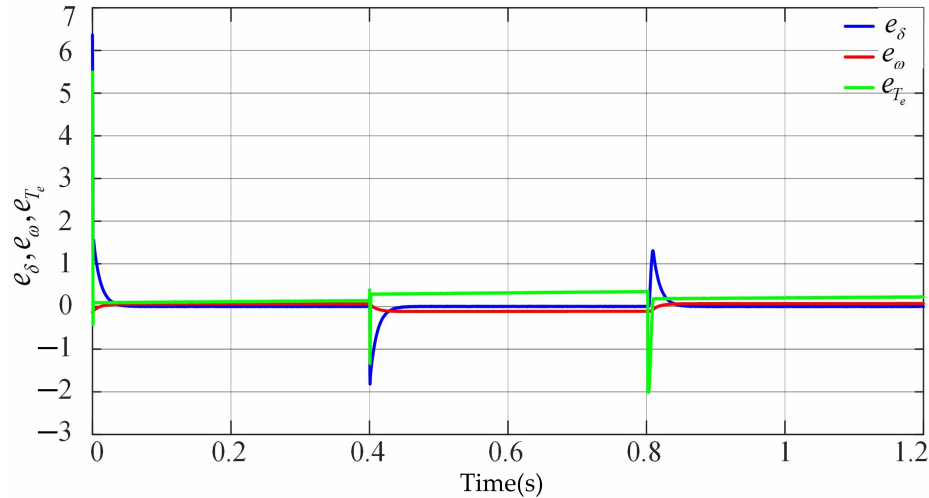
Figure 9. System tracking errors e δ , e ω , and e T